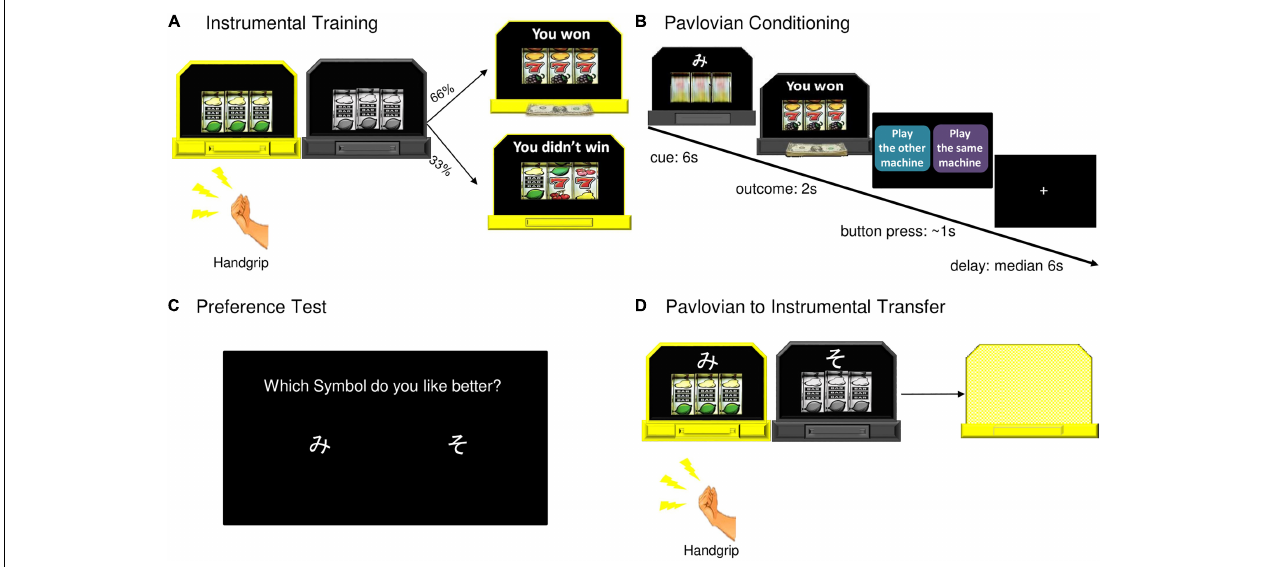
FIGURE 1 | Pavlovian-to-Instrumental Transfer task. (A) During instrumental training, one machine became available (lit up) for a participant to play (grip the hand dynamometer). Twelve ten second blocks with machines alternating, a 66% chance of winning on either machine. (B) During Pavlovian conditioning, one of two abstract symbols was paired with each slot machine. Machine A yielded reward 66% of the time (CS+, 44 trials), Machine B was never associated with winning (CS–, 44 trials). (C) After Pavlovian conditioning, participants were asked which of the two symbols (cues) they preferred. (D) During the transfer test, CS+ and CS– were displayed with slot machines, the outcomes “hidden” from the participants. There were six ten second blocks for each